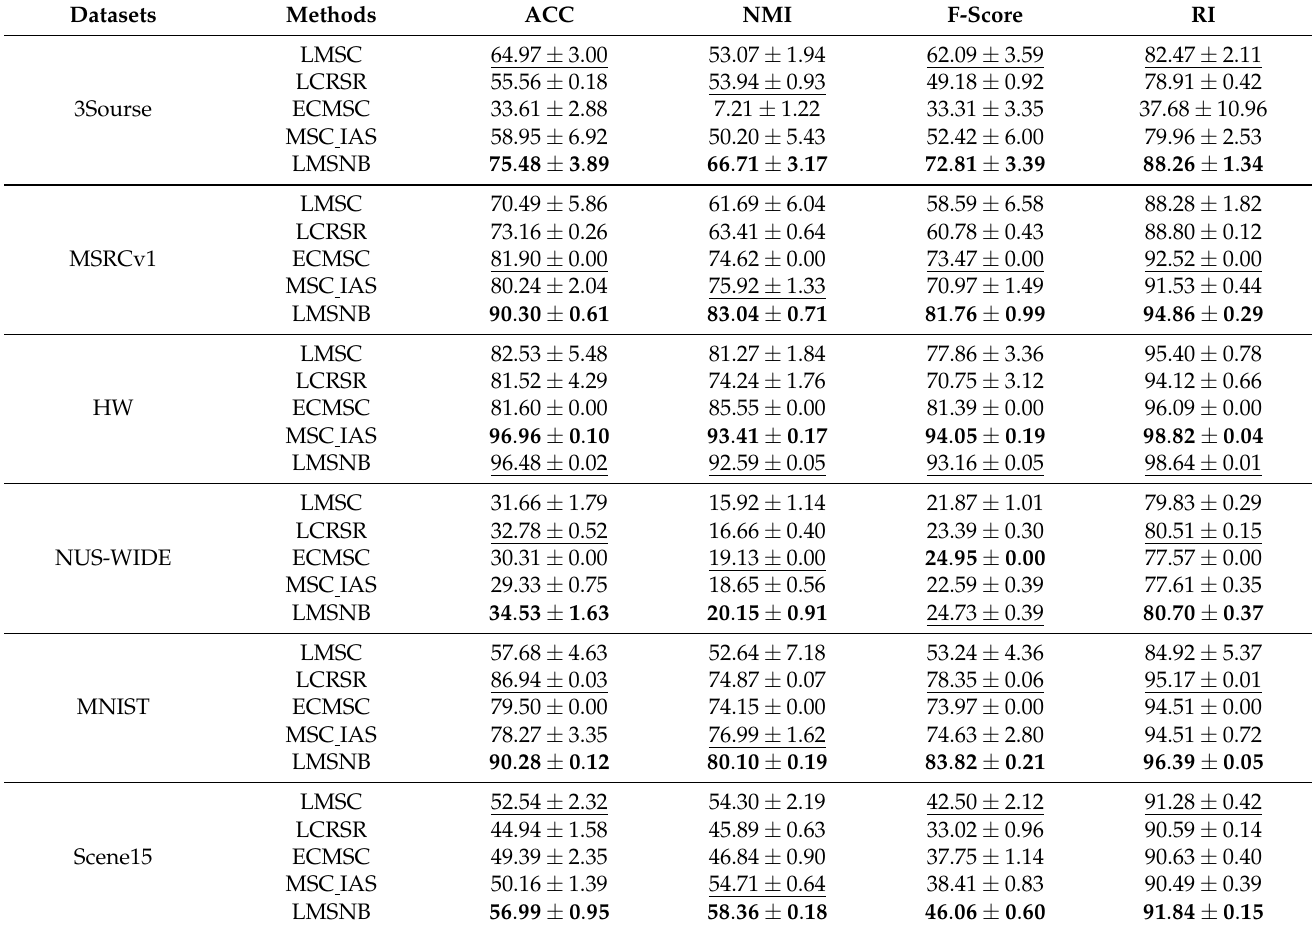
Table 3. Clustering performance on six datasets (mean ± standard deviation